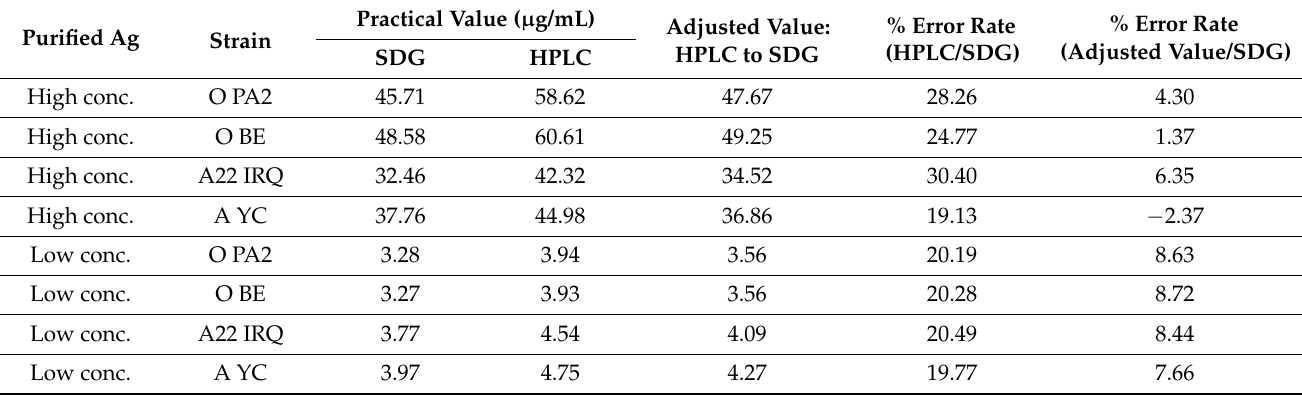
Table 1. Adjusting the 146S antigen quantitation value of SE-HPLC to that of SDG using the BEV standard: applied to high and low concentrations of purified vaccine antigens.